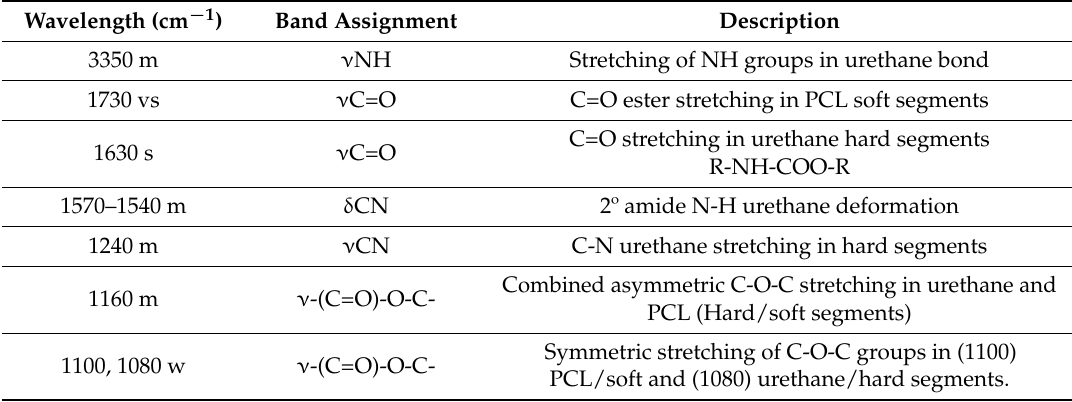
Figure 2. The FTIR spectra of non-crosslinked (black) and PVA-crosslinked PURs (blue and red respectively for 1 wt % and 2 wt % of PVA) in the range between 500–4000 cm − 1 ( a ) and in the range of 1000–2000 cm − 1 ( b ). Table 2 Band assignments of non-crosslinked and PVA crosslinked PURs.